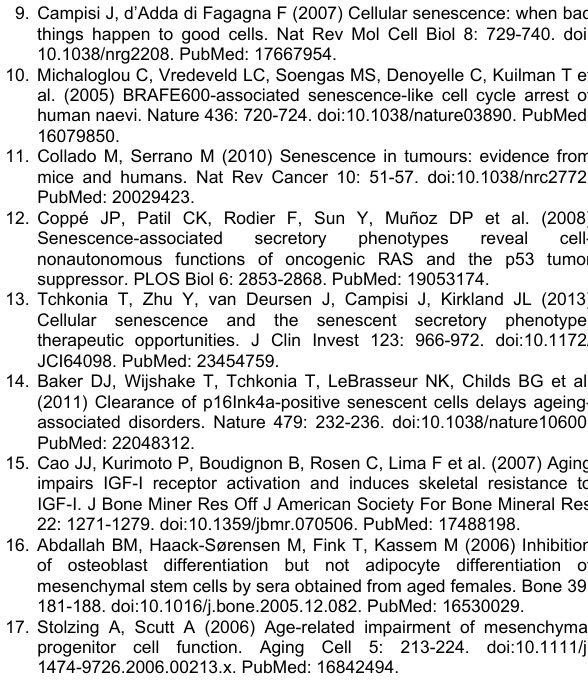
Figure S1. Forced expression of Osx does not rescue IR- induced blockade of osteogenesis in senescent MSC. MSC were transduced with GFP or Osx expressing lentiviral vectors and gene-modified cells selected with puromycine. Cells were then expanded for a few population doubling and forced expression of Osx determined by quantitative real-time PCR (A). In parallel, cell populations were exposed or not to IR and cultured under osteogenic conditions for 14 days and the ability to formed mineralized nodules in vitro evaluated (B). Mean ± standard error of at least three individual experiments is